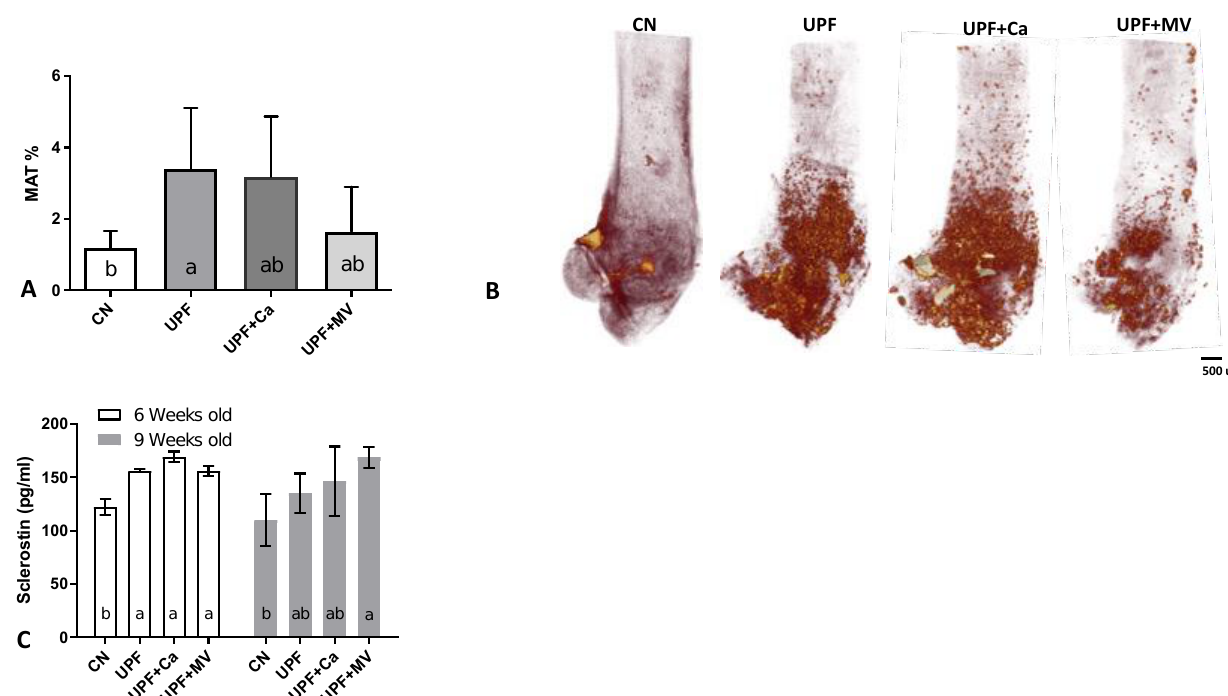
Figure 5. UPF effect on marrow adipose tissue of 9 weeks old mice. ( A ) Whole bone marrow adiposity (%) ( B ) 3D reconstruction of marrow adipose tissue after osmium tetroxide staining ( C ) Serum sclerostin (pg/mL). Values are expressed as mean ± SD, n = 8. Different letters denote p < 0.05 between groups. CN – control, UPF – ultra processed food, UPF+Ca - ultra processed food supplemented with calcium, UPF+MV - ultra processed food supplemented with multivitamin and mineral complex.